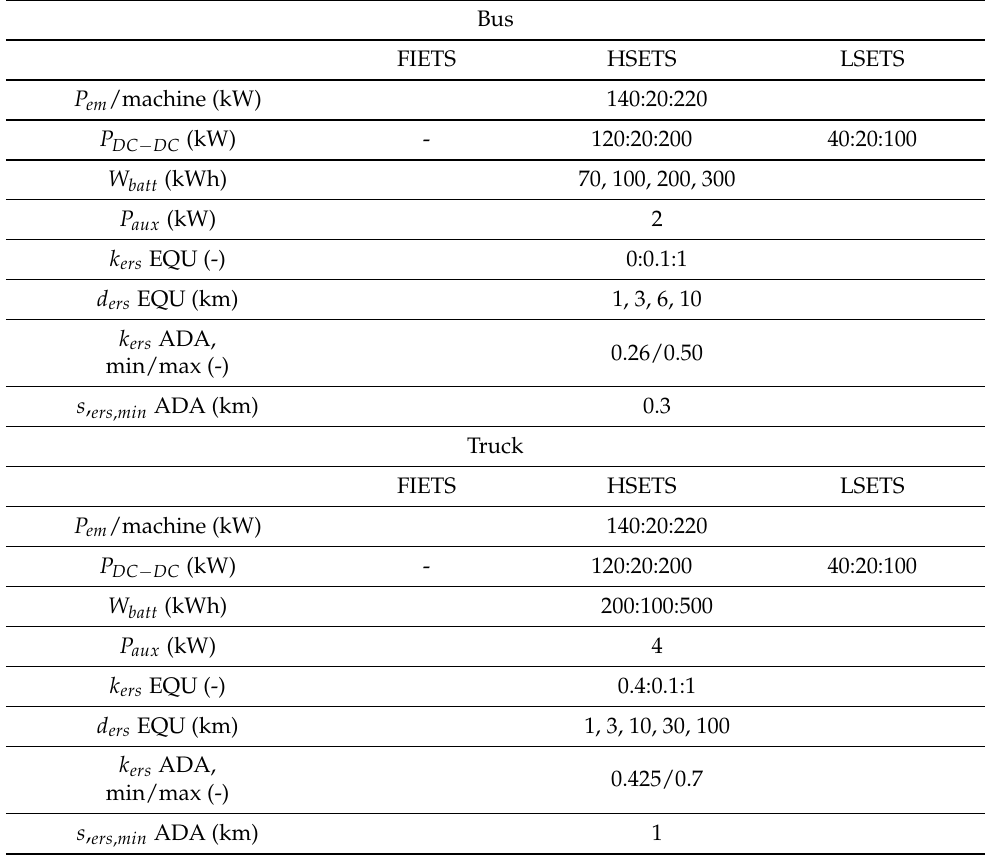
Table 3. Rating of ETS components and